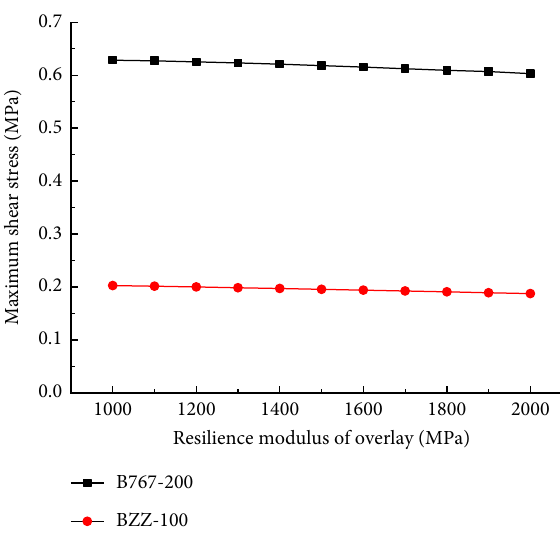
Figure 5: Effect of overlay thickness on maximum shear stress.